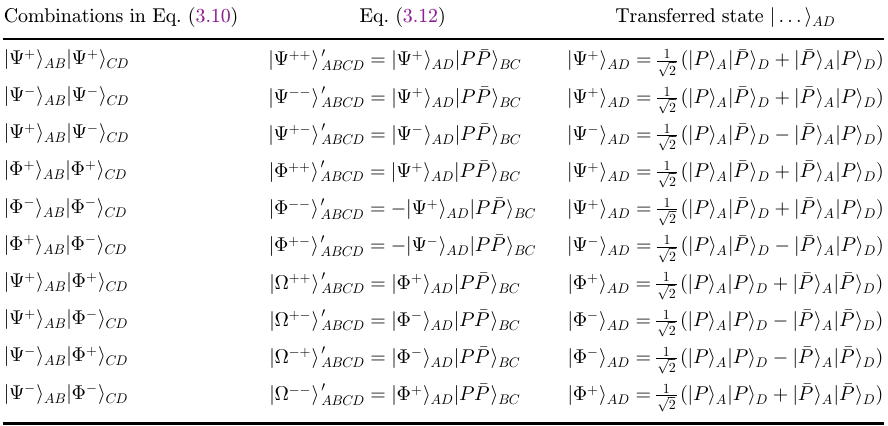
Table 2. Transfer of packaged entangled states. Combinations in Eq. (3.10) Eq. (3.12) Transferred state j ... i